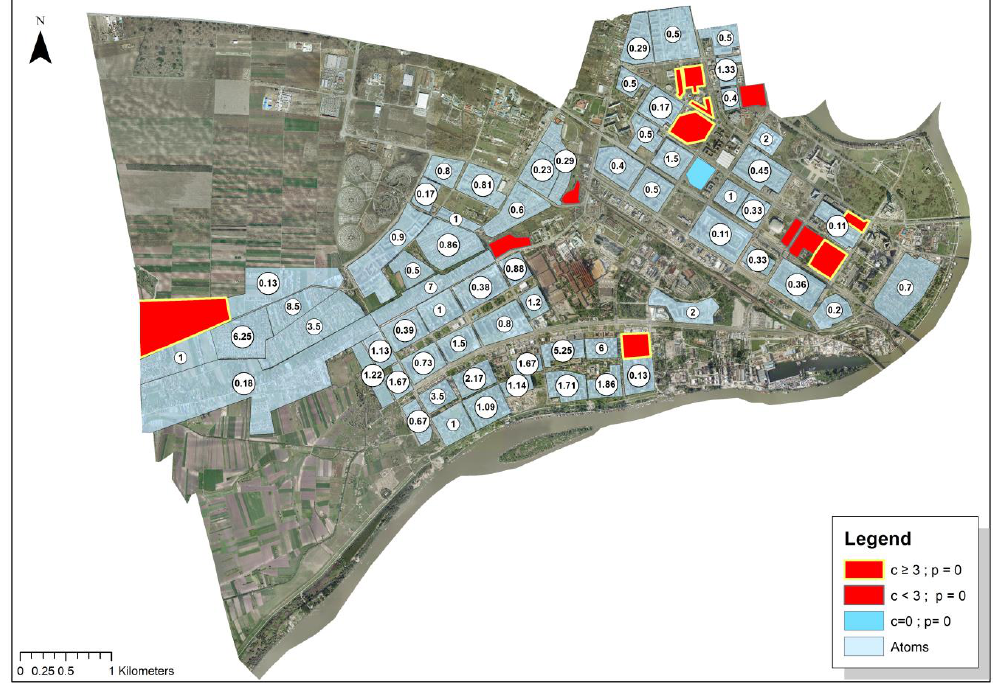
Figure 2. Different index measure (IM) values in the research area.